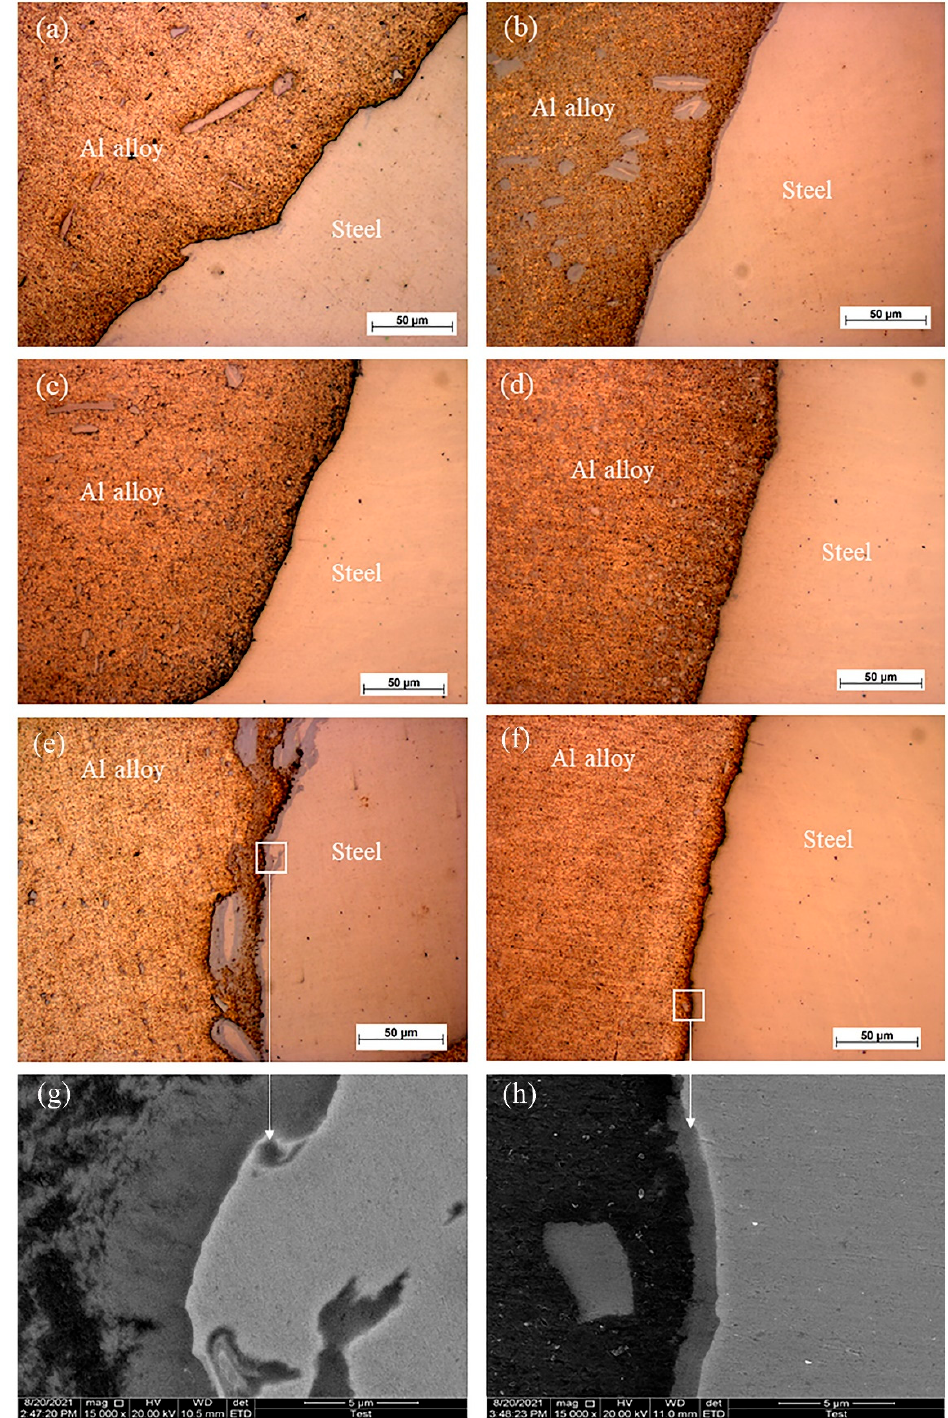
Figure 5. Details corresponding to the partially enlarged images in Figure 4 and the SEM image. ( a ) HRS-FSW Al-Fe interface under a high tool offset ( b ) HRS-FSW Al-Fe interface under a low tool offset. ( c ) Ultra-HRS-FSW Al-Fe interface under a high tool offset. ( d ) Ultra-HRS-FSW Al-Fe interface under a low tool offset. ( e ) RS side interface and SEM picture of HRS-FSW under a low tool offset. ( f ) RS side interface and SEM picture of ultra-HRS-FSW under a low tool offset. ( g ) Partial magnification in Figure ( e ). ( h ) Partial magnification in Figure ( f ).